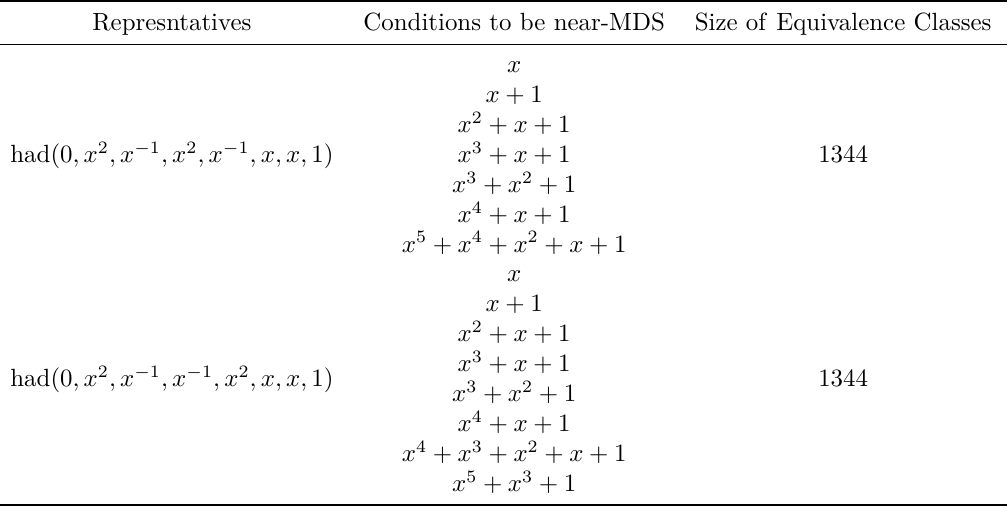
Table 7: Involutory near-MDS Hadamard matrices of order